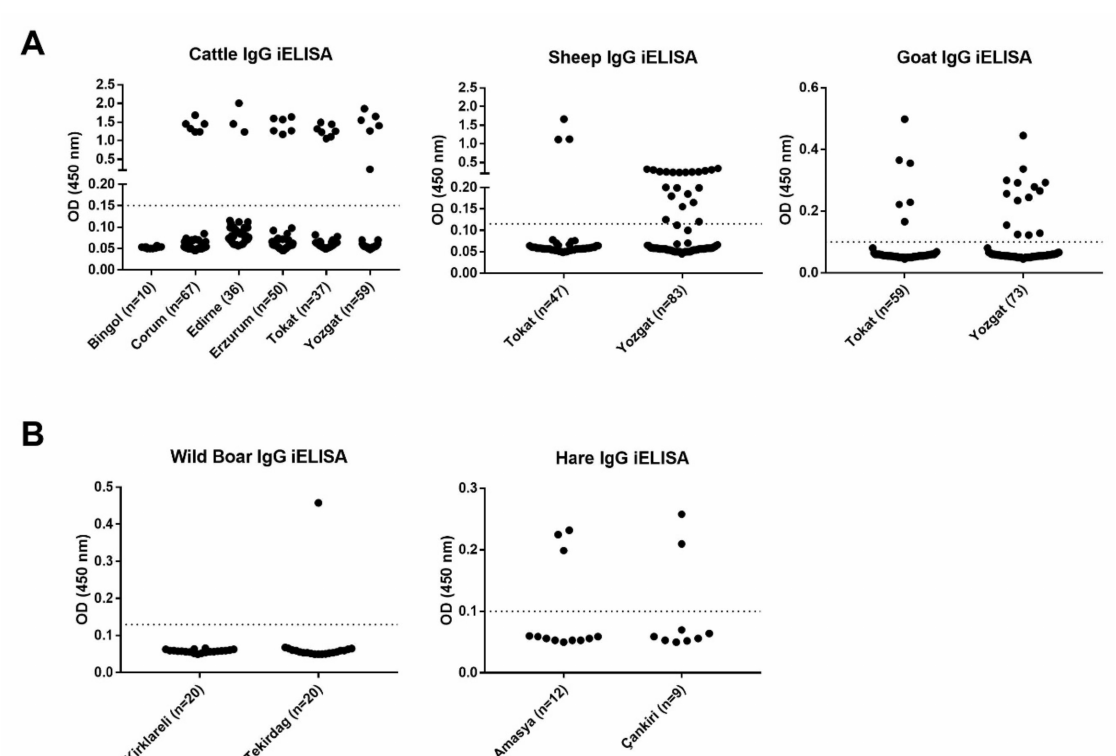
Figure 2. Indirect IgG results showing OD results obtained from iELISA. An optimized in-house iELISA was performed on heat (56 ◦ C) inactivated serum samples. Serum samples were collected from domestic ( A ) and wild animals ( B ) located in different regions of Turkiye (cattle iELISA cut-off: 0.15, sheep iELISA cut-off: 0.11, goat iELISA cut-off: 0.11, wild boar iELISA cut-off: 0.13, hare ELISA cut-off: 0.11). Dotted line represents the OD cut-off threshold (GMTx2.5 of negative assay controls) and black dots represent individual OD